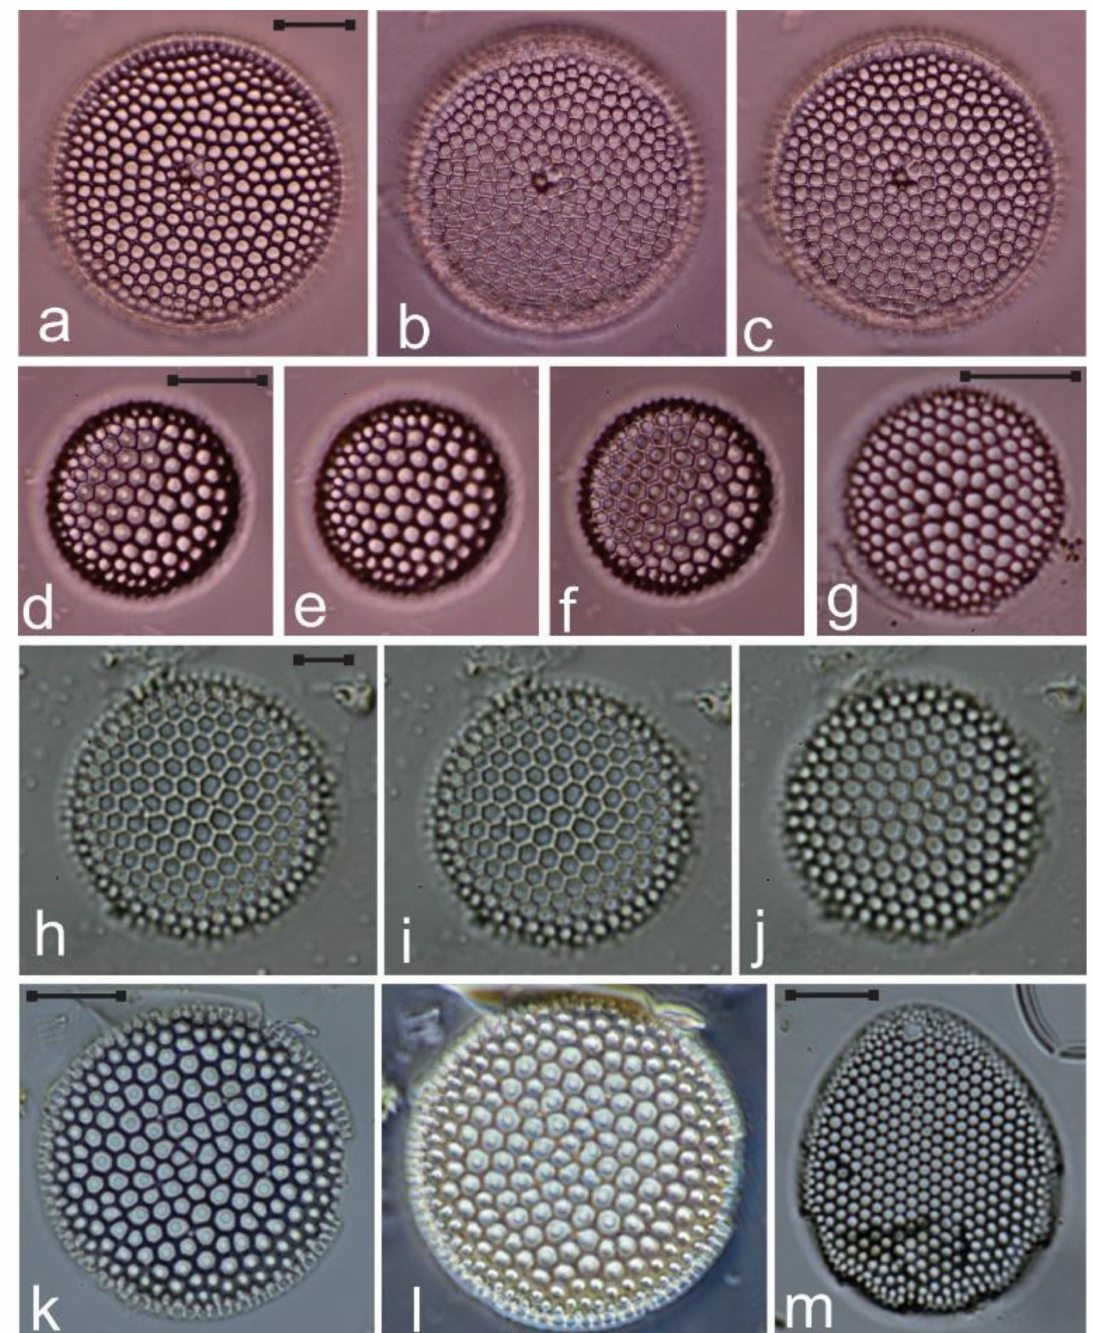
Figure 7. ( a – g ) Azpeitia nodulifera in di ff erent focal planes and showing range in size; ( h – j ) Thalassiosira nanolineata ; ( k , l ) Coscinodiscus radiatus in di ff erent focal planes; ( m ) Roperia tesselata . Scale bar = 10 µ